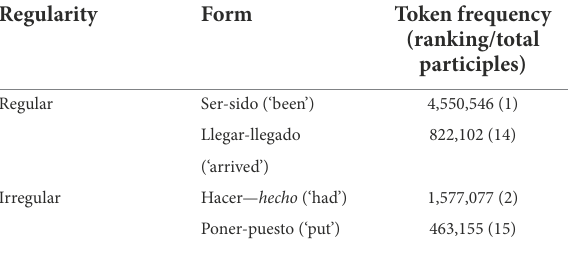
TABLE 1 Token frequencies of regular and irregular Spanish past